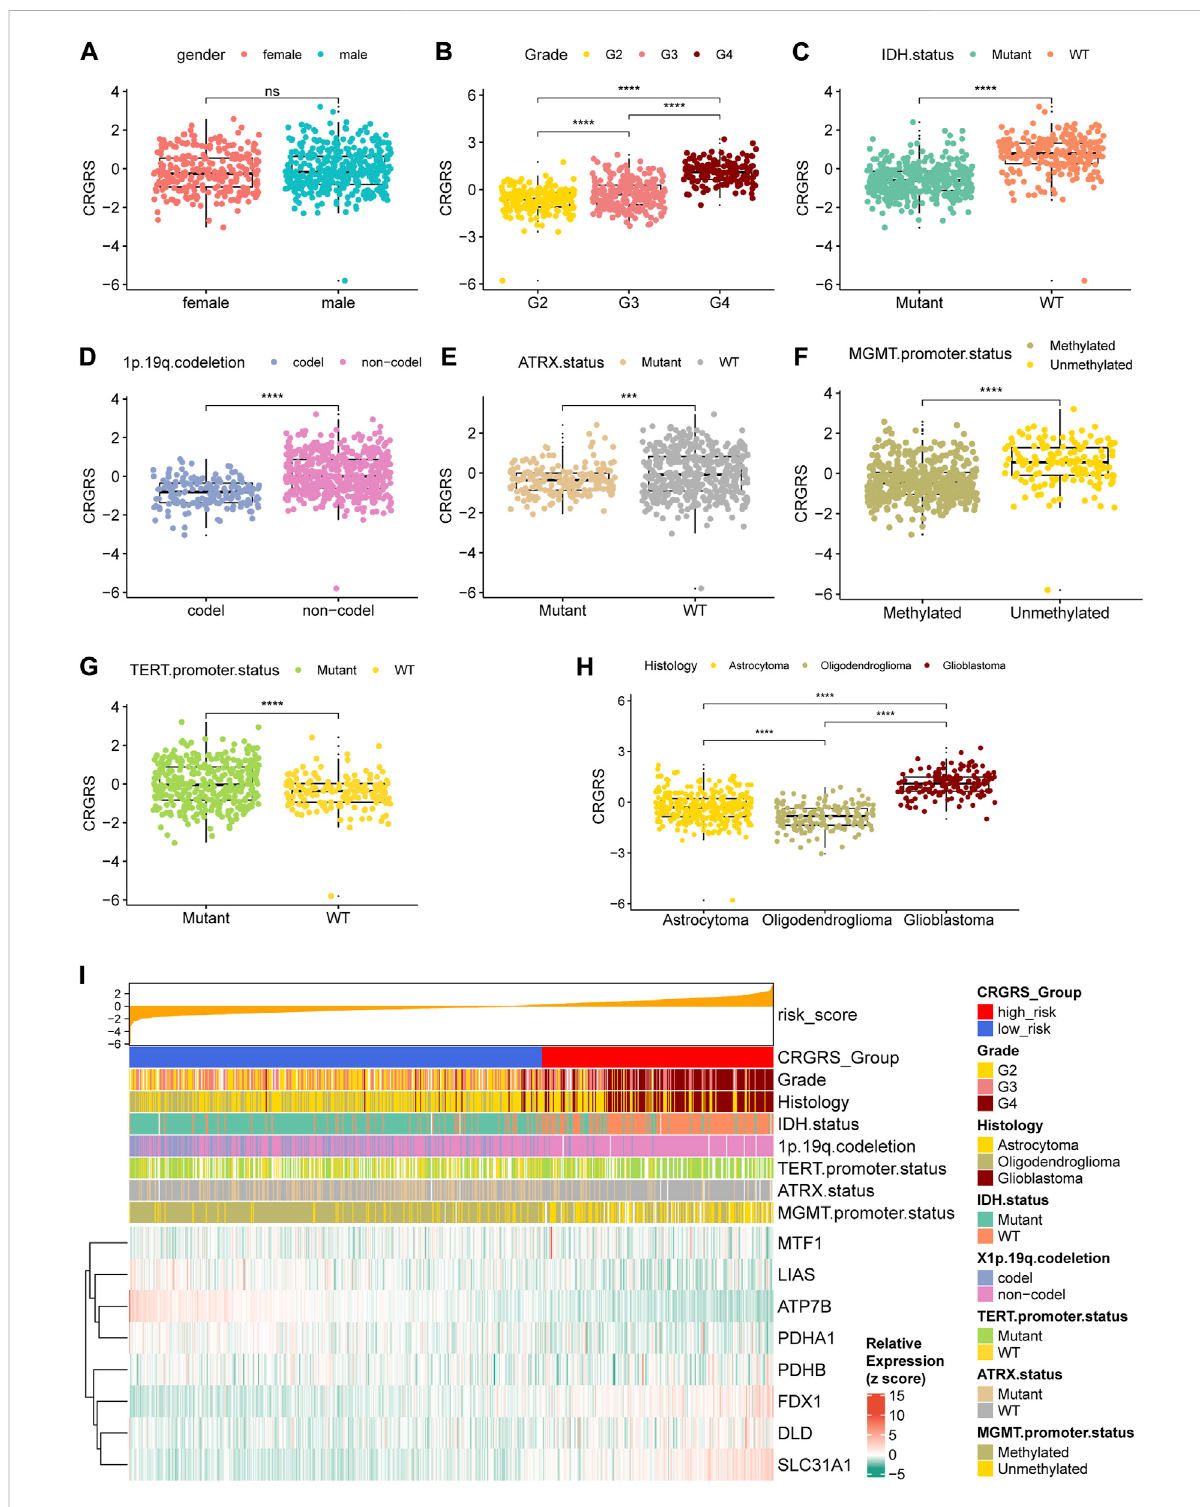
FIGURE 7 RelationshipbetweenclinicopathologicalfeaturesandtheCRGRS.ThedifferencesinCRGRSwithrespectto (A) gender, (B) WHOgrade, (C) IDH status, (D) 1p19q codeletion, (E) ATRX status, (F) MGMT promoter methylation, (G) TERT promoter mutation, (H) Histology diagnosis. (I) Heatmap sorted by CRGRS, elucidated clinicopathological features and expression of 7 critical CRGs in the TCGA cohort. * p < 0.05; ** p < 0.01; *** p < 0.001; **** p <